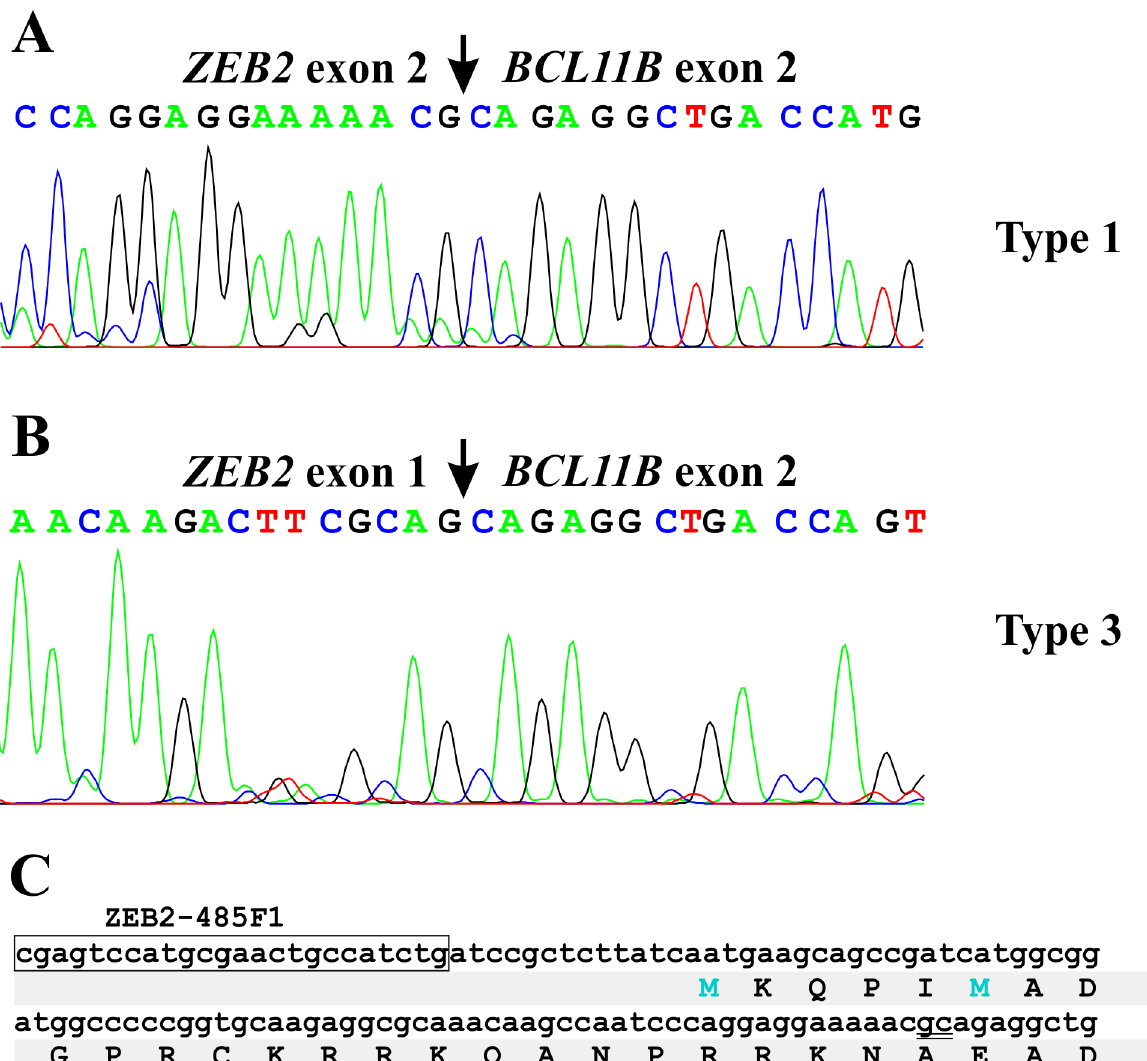
Fig 3. Sanger sequence of the amplified products from the AML patient with the chromosomal aberration t(2;14). A) Partial sequence chromatogram of the cDNA fragment showing that exon 2 of ZEB2 is fused to exon 2 of BCL11B (type 1 fusion transcript). B) Partial sequence chromatogram of the cDNA fragment showing that exon 1 of ZEB2 is fused to exon 2 of BCL11B (type 3 fusion transcript). C) Sequence of the amplified cDNA fragment using the primers ZEB2-485F1 and BCL11B-654R1 (shown in box). The fusion point “ gc ” is double underlined. The open reading frame is also shown.